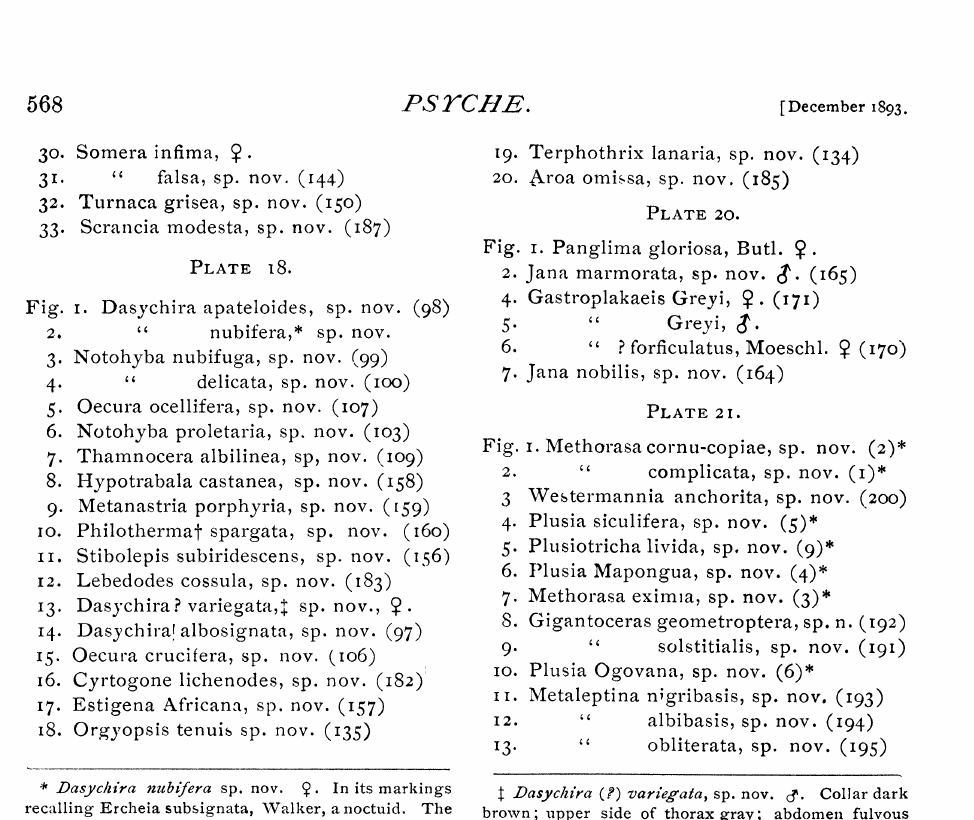
primaries creamy marked with brovn spots and lines. Of these the most conspicuous basal spot, broad sub-basal brovn band margined both sides with paler, large ovoid spot at the end ofthe cell, tri- angular subapical spot of brown the costa, smaller brown spot near the outer angle and series of ginal lunulate markings. The secondaries white narrowly margined with pale brown. The marginal series of lunulate markings is continued from the prim- aries, and there is subtriangular brown spot at the anal angle. On the under side both wings paler and the markings more obscure. ?. The female is like the male, but the spots , broader and more diffuse. Expanse o*, 4 to 50 mm.; .5,5